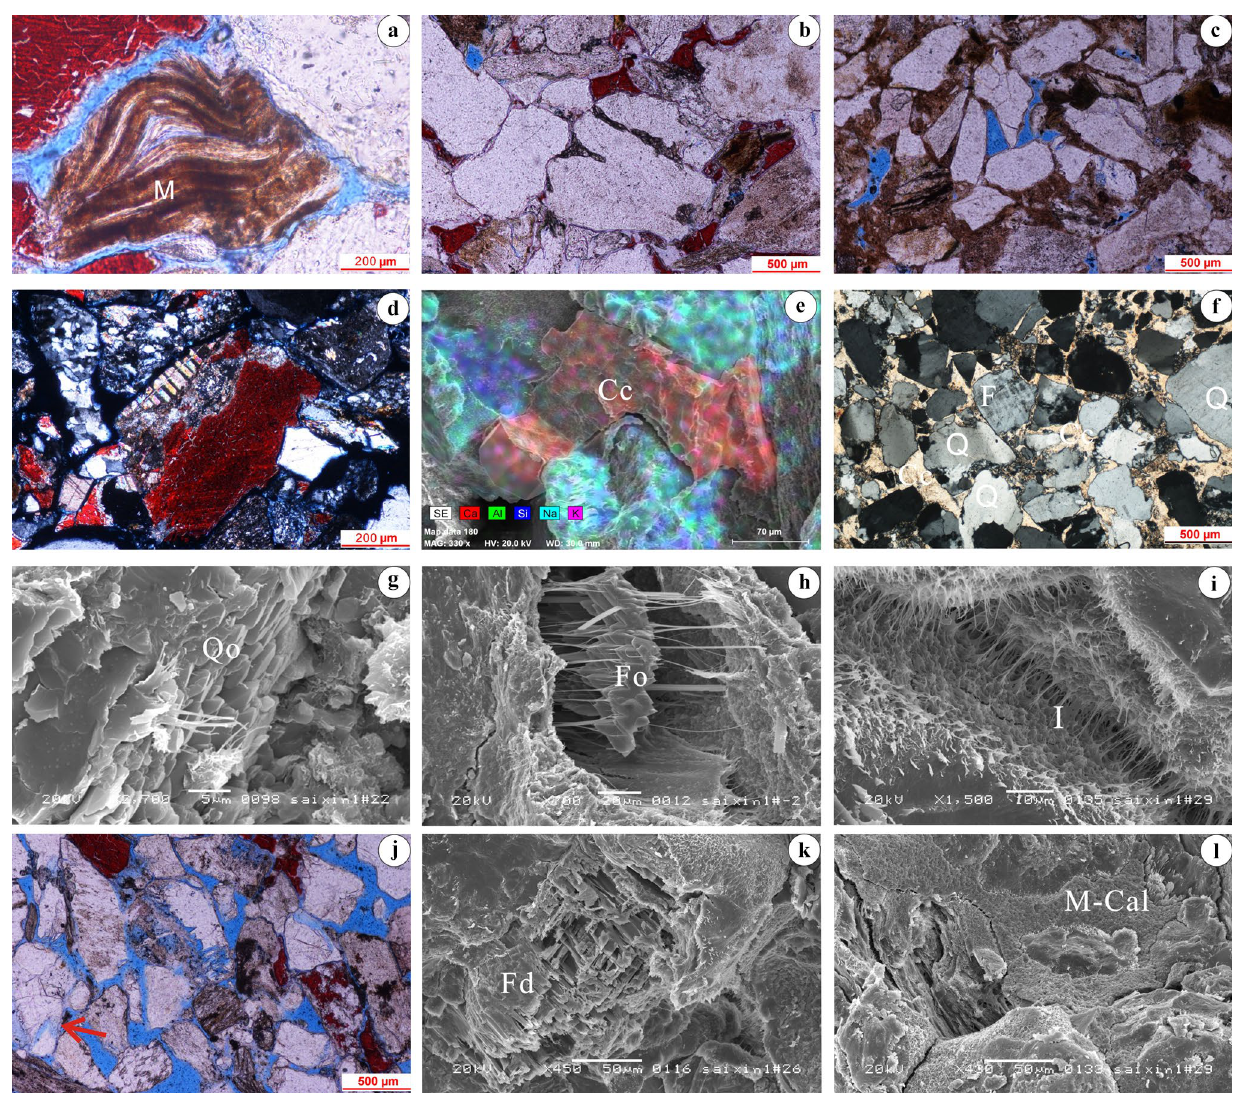
Fig. 9 a Optical photomicrograph of deformation of a mica as a result of compaction, well SX1, 1321.0 m (–). b Optical photomicro- graph of line contacts and line-concavo-convex contacts of quartz, well SX1, 1310.50 m (–). c Optical photomicrograph showing point contacts and line contacts of quartz, well SX1, 1460.5 m (–). d Opti- cal photomicrograph displaying carbonate cements precipitate in the pores among particles and intragranular dissolution pores, well SX1, 1310.5 m (–). e Energy spectrum analysis photomicrograph of well SX1, 1466.50 m, ×330. f Optical photomicrograph display- ing calcite cements totally block the pore, Well Ld1, 1628 m (–). g SEM image of overgrowth of quartz, well SX1, 1454.00 m, ×2700.